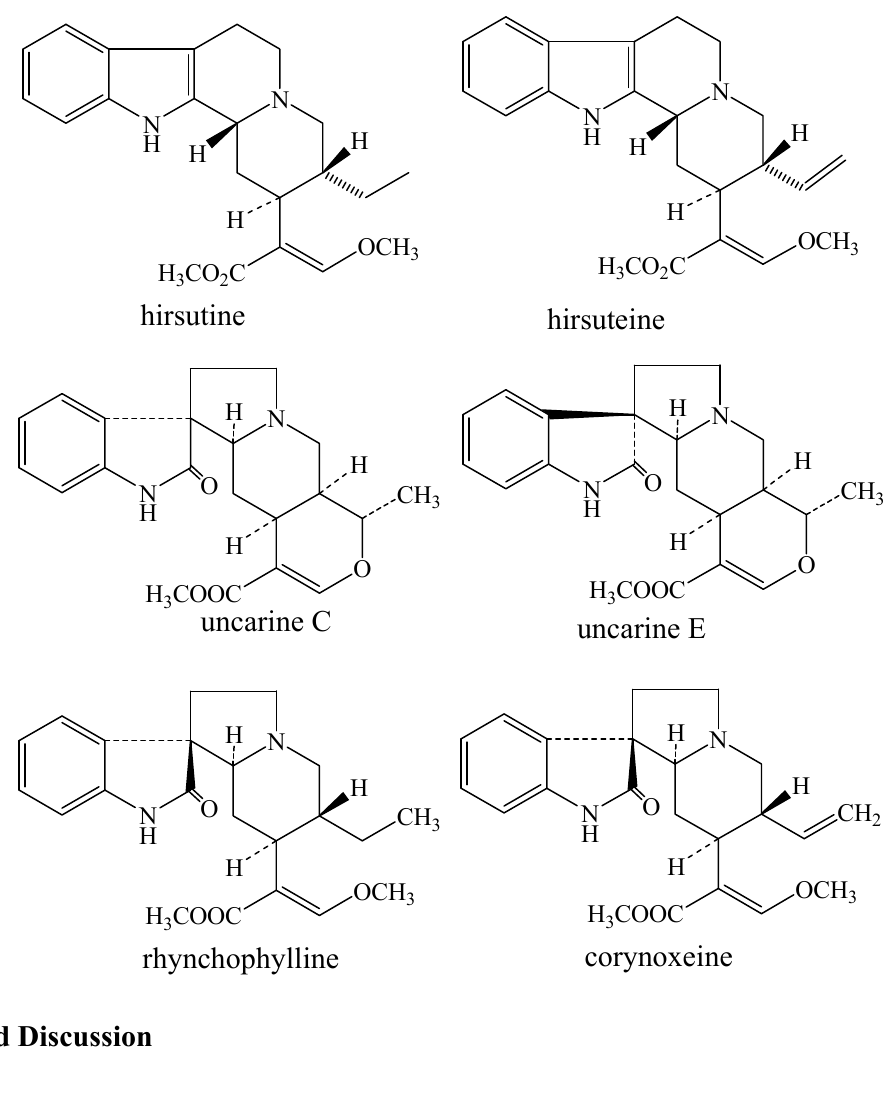
Figure 1. Chemical structures of alkaloids from U. rhynchophylla